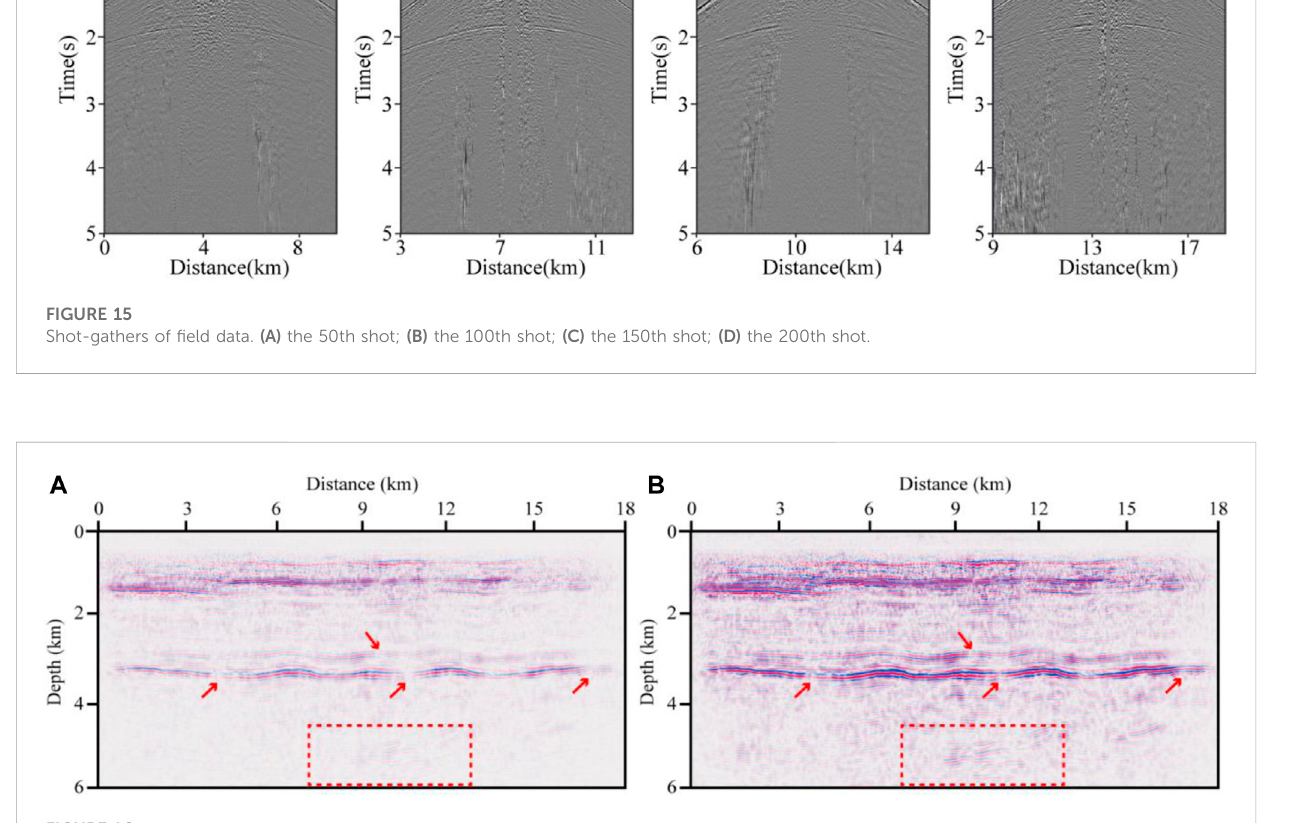
FIGURE 16 Migrated images of the fi eld data. (A) acoustic RTM; (B) constant-order compensated